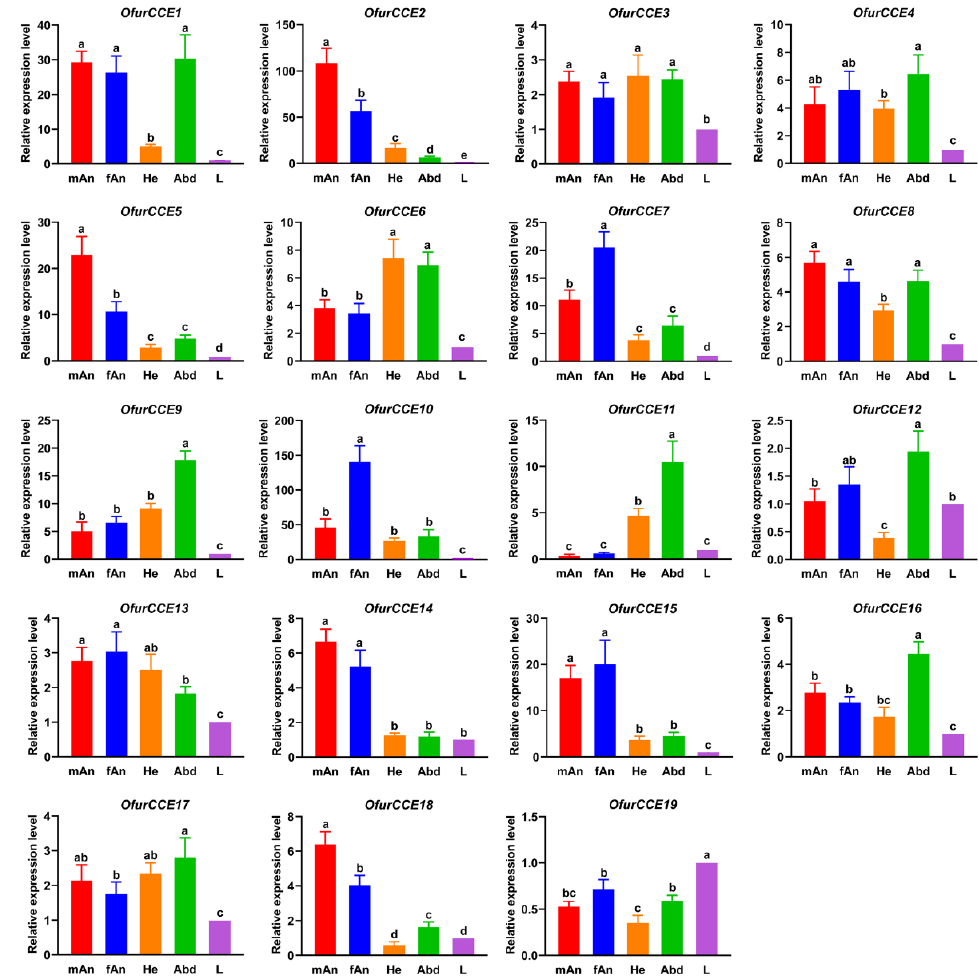
Figure 7. Relative expression levels of Ostrinia furnacalis CCE s in various adult tissues. mAn, male antennae; fAn, female antennae; He, heads; Abd, abdomens; L, legs. Results are means of three biological replicates ± standard error (SE). The average expression value of each CCE gene in the leg was set to one. Different lowercase letters indicate significant variation in transcription among different tissues (one- way ANOVA with Tukey’s test, p < 0.05).